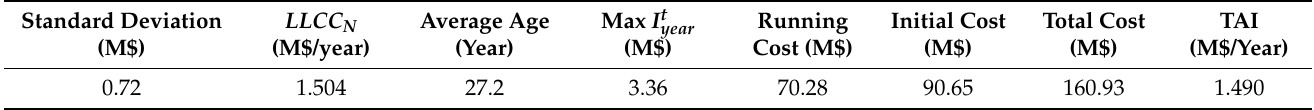
Table 3. Details of the investment before smoothing.